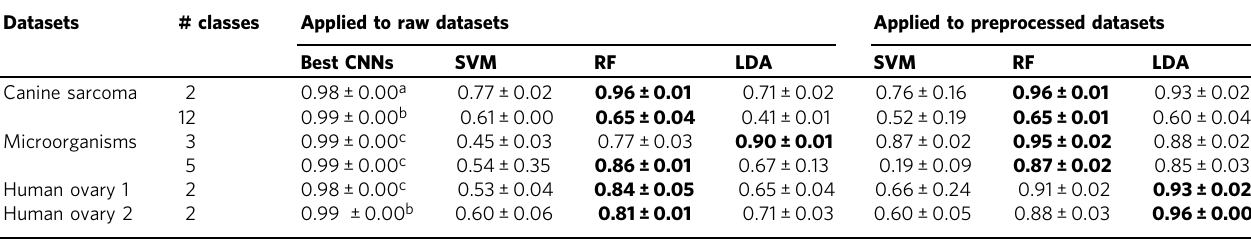
The best result for each task (accuracy±standard variation over 10 independent iterations) is indicated in boldface. a The best CNNs from scratch. b The best CNNs after cumulative learning. c The best CNNs after transfer